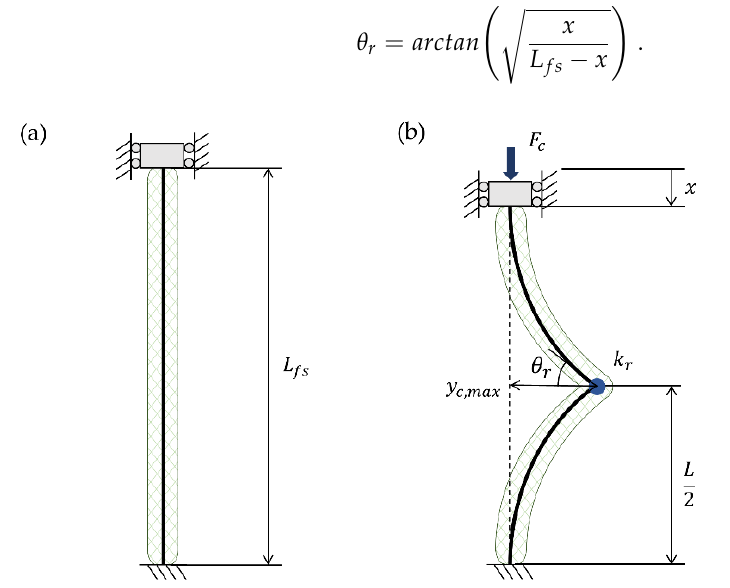
Figure 5. Parameters of McKibben actuator at free strain ( a ) and in the post-collapse region repre- sented by the clamped-hinged-clamped column mode shape ( b ).